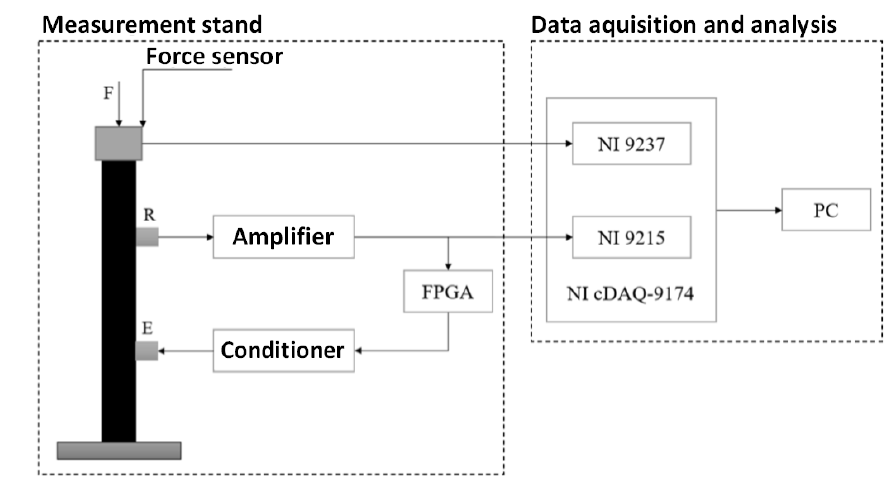
Figure 3. Schematic of laboratory stand with data acquisition module.